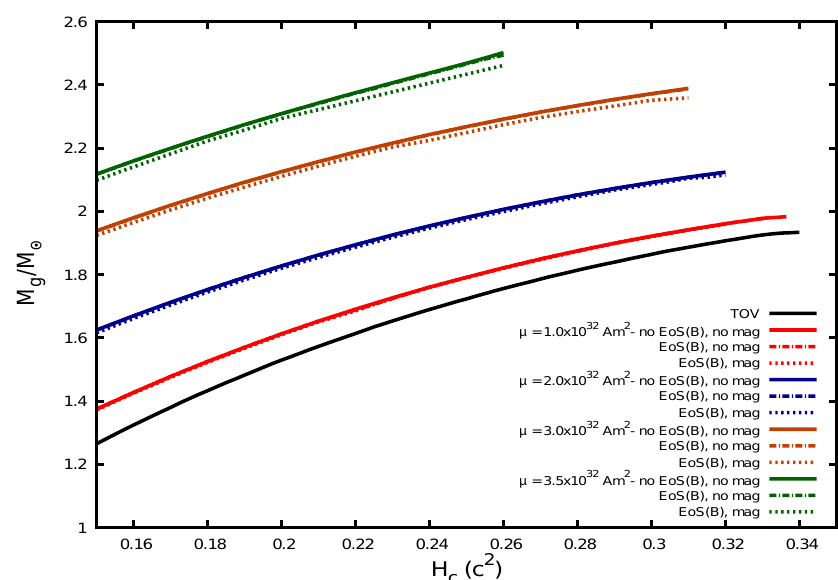
Figure 2. Equilibrium sequence obtained from the numerical solution of he Einstein-Maxwell equations for the CMF model equation of state shown for different dipole magnetic moments including different magnetic field